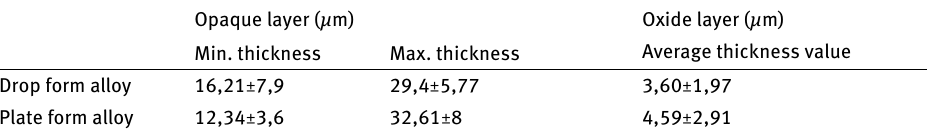
Table 3: Results of opaque and oxide layer assessments.